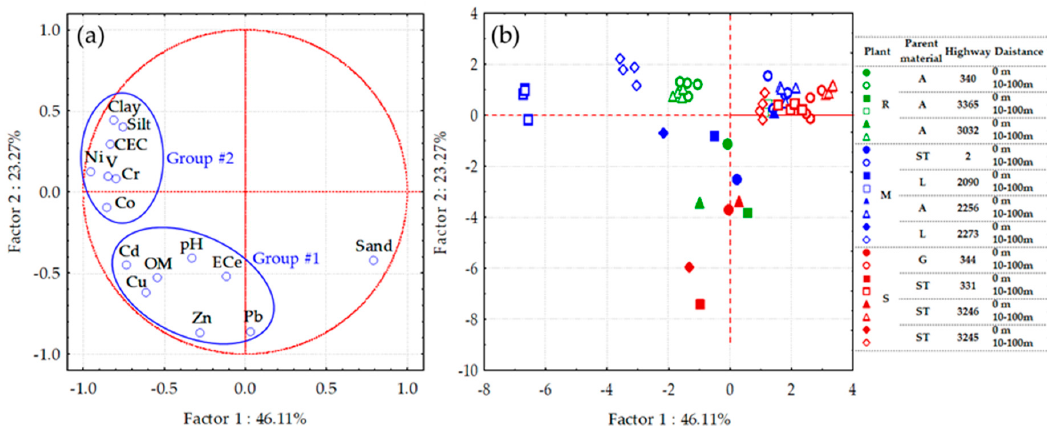
Figure 5. Principal component analysis (PCA) for metal concentrations and soil properties for bulk soil samples of roadside agricultural soils in Thailand: ( a ) distribution of metal contents and soil properties (variables); and ( b ) distribution of the studied soil samples in relation to plant types (R = rice; M = maize; S = sugarcane), soil parent materials (A = alluvial; ST = sandstone; L = limestone; and G = granite), highway numbers, and the distances from the road edge